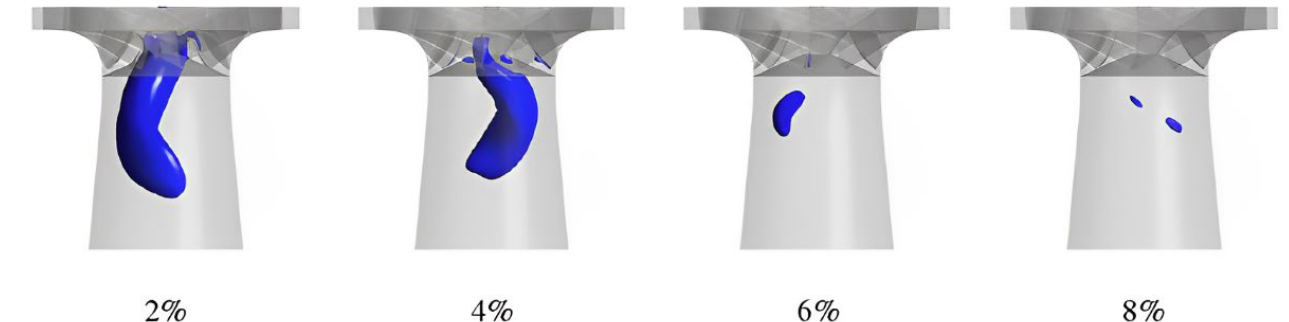
Figure 21. The shape of the vortex rope under different air supply volumes [77].